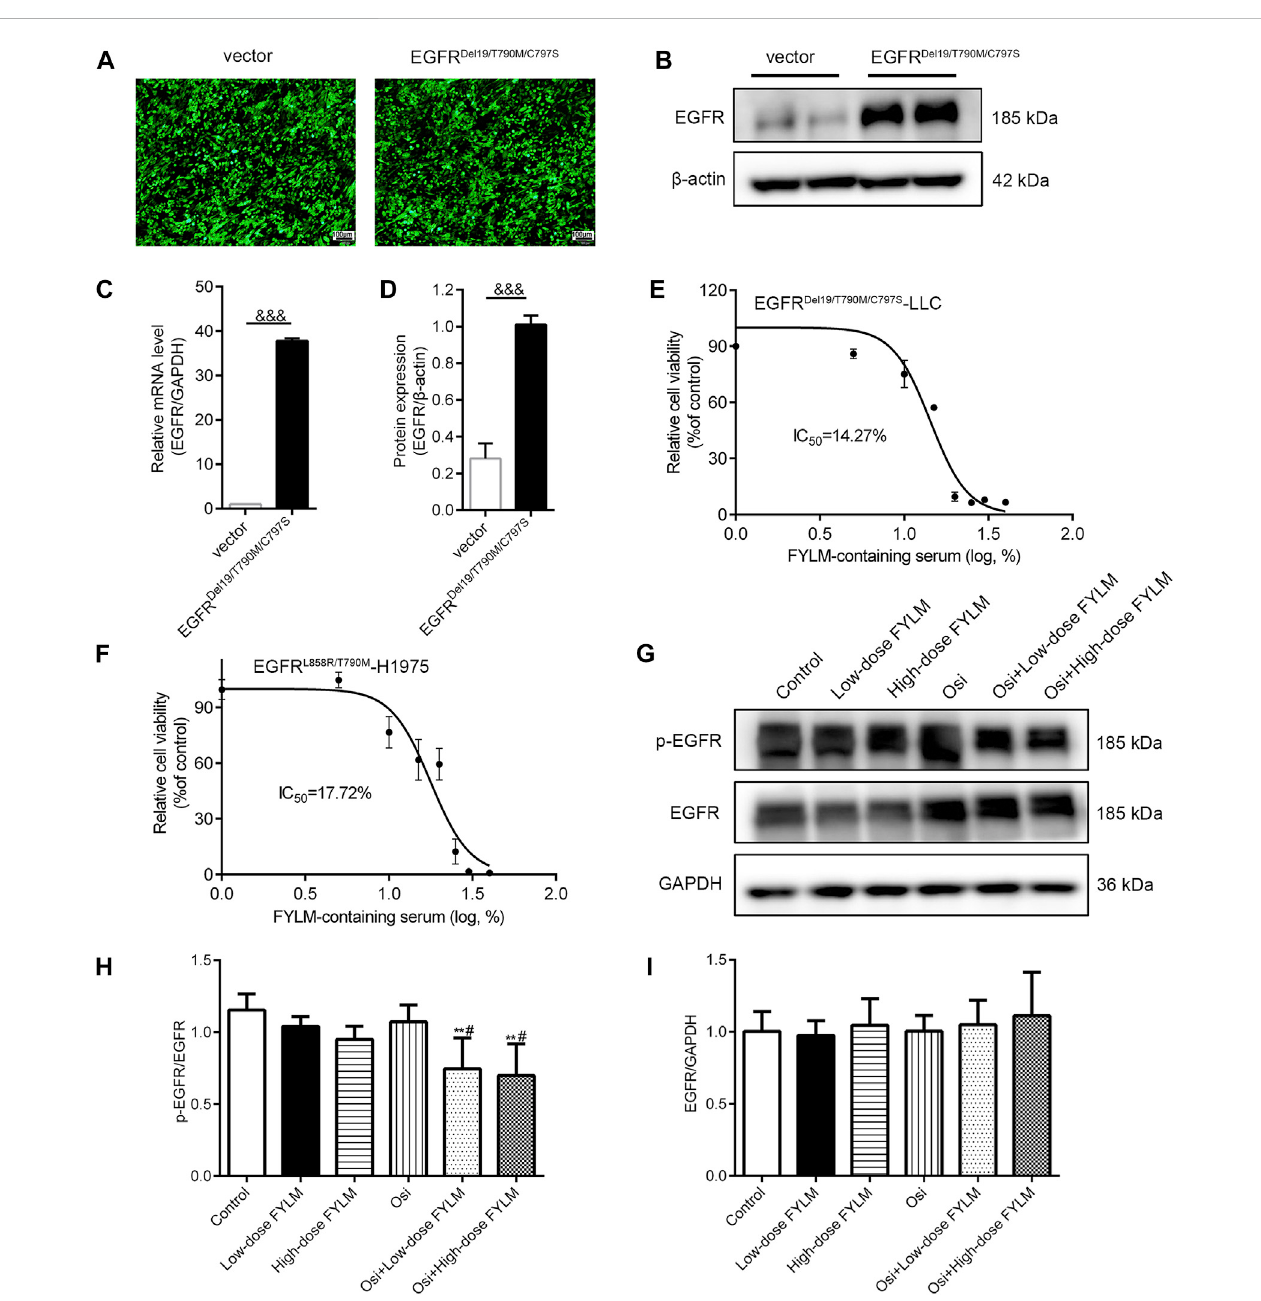
FIGURE 2 FYLM-containing serum inhibited cell proliferation and reduced EGFR phosphorylation in vitro . The (A) fl uorescence intensity, (B) western blot and (C) real-time qPCRresultswereusedtoidentifythetransfection effectoftheemptyvector andEGFR Del19/T790M/C797S mutantlentivirus inLLCcells. (D) Quantitative analysis of EGFR protein levels. (E,F) MTT assays determined relative cell viability in LLC-EGFR-Del19/T790M/C797S cells and H1975-EGFR-L858R/T790M cells treated with FYLM-containing serum for 48 h (G) LLC-EGFR-Del19/T790M/C797S cells were treated with low and high doses of FYLM-containing serum and Osi alone or in combination. p-EGFR and EGFR protein were detected by western blotting. (H,I) Quantitative analysis of p-EGFR and EGFR protein levels. &&& p < 0.001 vs. vector; ** p < 0.01 vs. Control; # p < 0.05 vs. Osi. Osi, osimertinib. All data are shown as mean ±